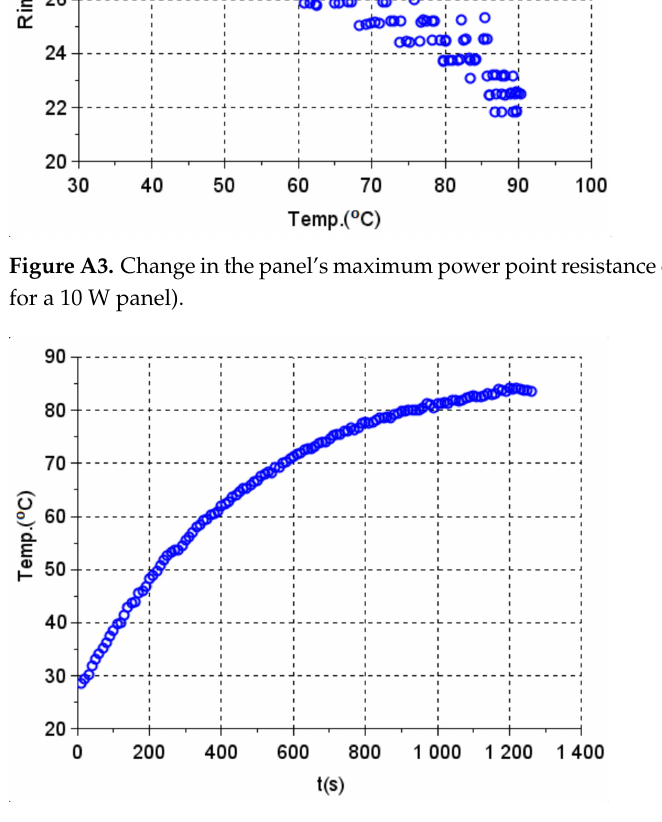
Figure A4. The heating curve of a 10 W PV panel illuminated with halogen lamps (1000 W/m 2 ). Table A1. Detailed parameters of the 10 W PV panel under standard test